Question: Generate an informative caption for the figure above.
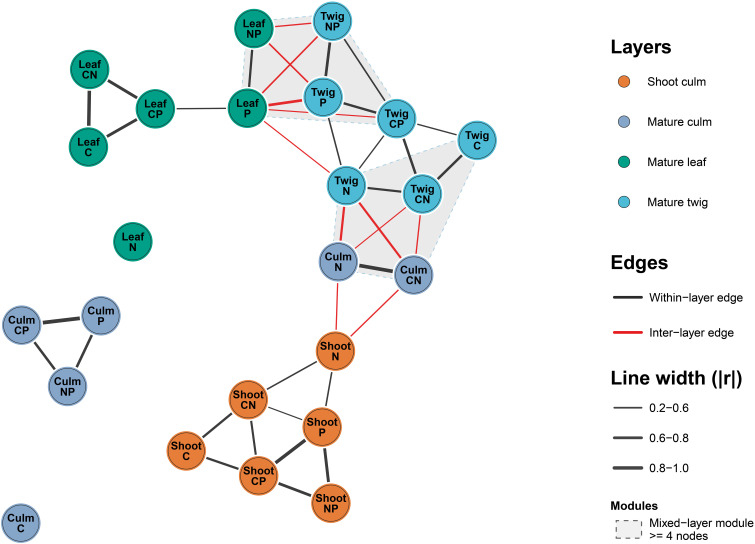
Answer: A multilayer network of Fargesia denudata stoichiometric traits. Onlycorrelations meeting the retained-edge criteria are shown (|r| > 0.2, FDR-adjusted p ≤ 0.05). In the network, Shoot refers to shoot culm, whereas Culm, Leaf, and Twig represent traits only at the mature stage. C, C concentration; N, N concentration; P, P concentration; CN, C:N ratio; CP, C:P ratio; NP, N:P ratio. The complete pairwise correlation table is provided in Supplementary Table 1 .